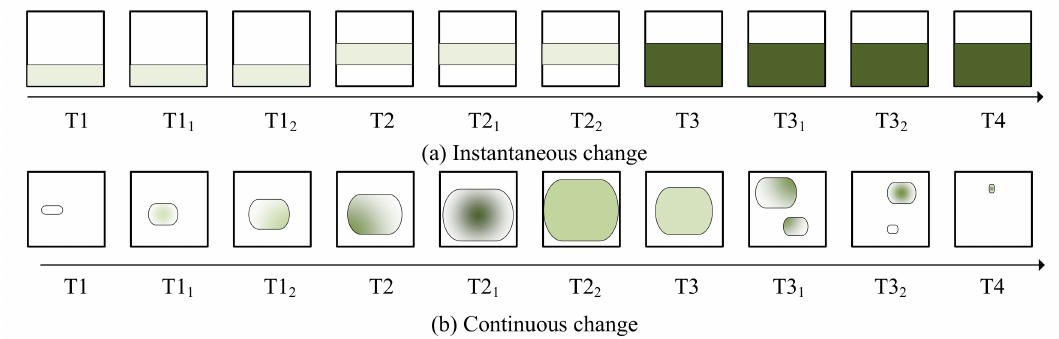
Figure 1. Comparisons of the ( a ) instantaneous and ( b ) continuous